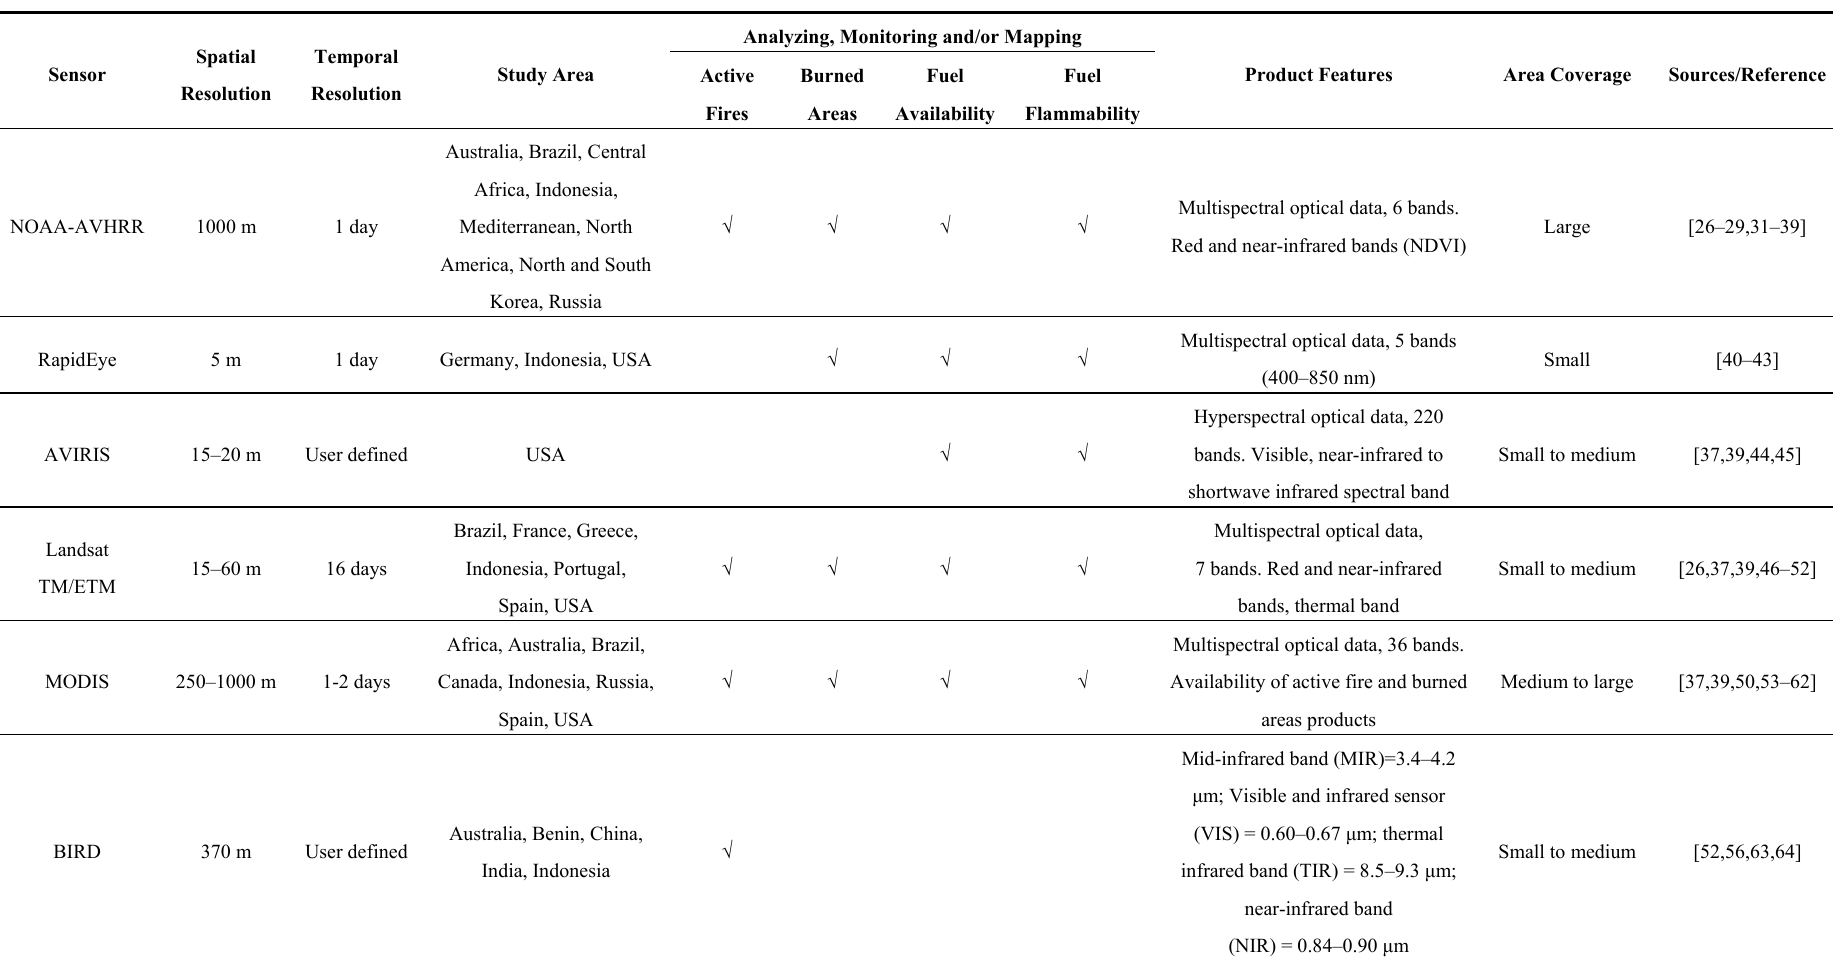
Table 1. Examples and description of current remote sensing applications and their capabilities for monitoring and/or mapping active forest fires, burned areas, fuel availability, fuel flammability (marked with a √ whenever the tool was found suitable for each specific